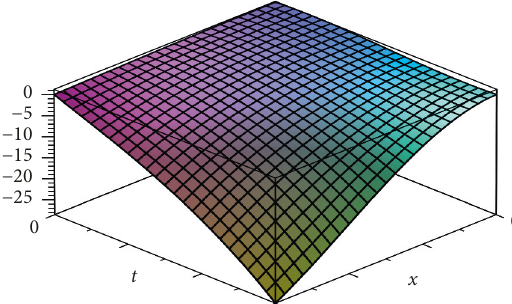
Figure 5: The approximate solution of ζ